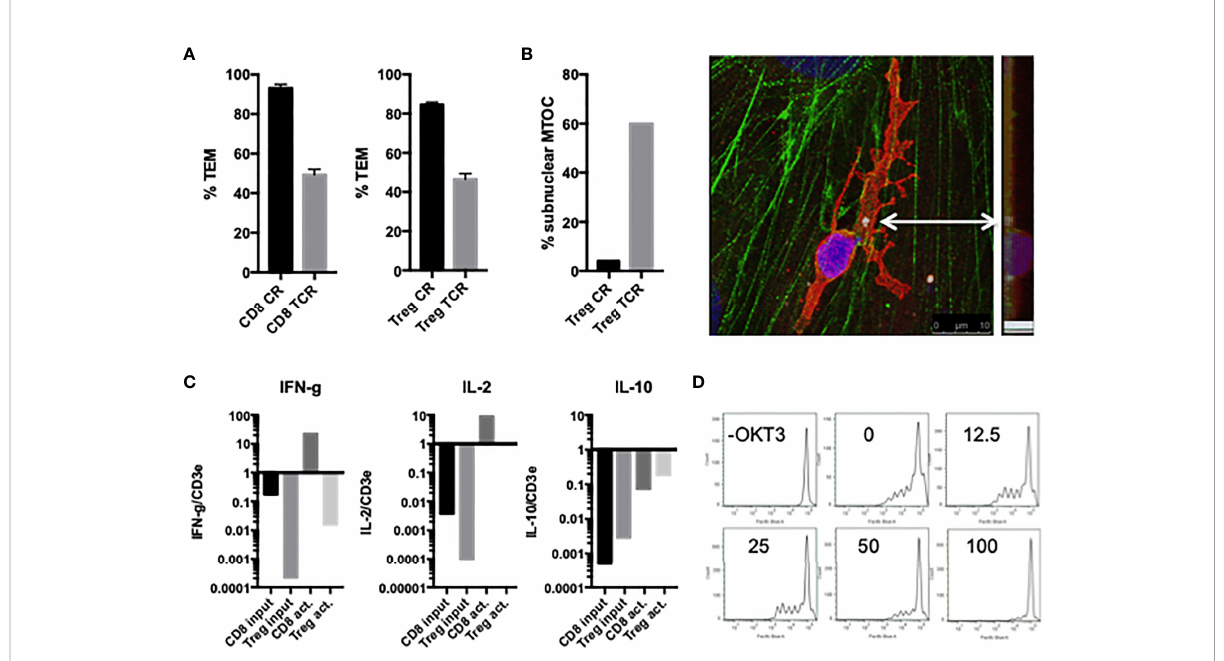
FIGURE 6 Characterization of activated/expanded CD8 T EM and CD4 Treg. (A) TEM of activated and expanded CD8 T EM and CD4 Treg whether activated by superantigen presented by EC (TCR) or not (CR) after 60 min fl ow. (B) MTOC polarizes between the activated Treg cell nucleus and EC surface at early time points (left graph), and then precedes the nucleus during diapedesis (image of confocal slices merged and viewed from on top and at a 90 degree angle). Samples stained for VB2TCR (red) gamma tubulin (white, indicated by arrow) phalloidin (green) and DAPI (blue). (C) Relative cytokine expression levels in activated/expanded CD8 T EM and CD4 Treg. (D) Treg suppression assay. 250,000 PBMC stained with Cell Trace Violet in the present or absence of CD3activating Ab OKT3 were incubated with 100,000, 50,000, 25,000, 12,500 or 0 activated/ expanded CD4 Treg for 5 d, stained with CD8-APC, and analyzed by FACS. Shown are histograms of CD8+